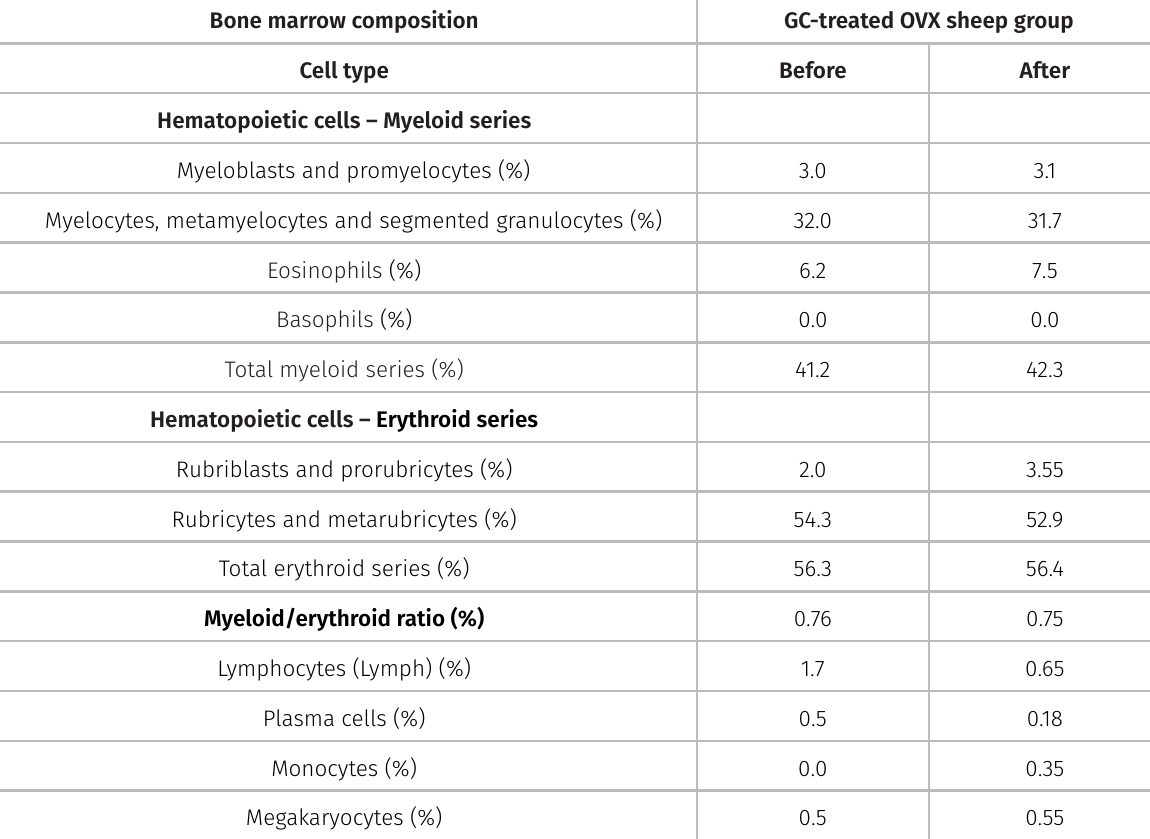
Table III. Bone marrow composition before and after OVX and exogenous GC administration in sheep (median values).